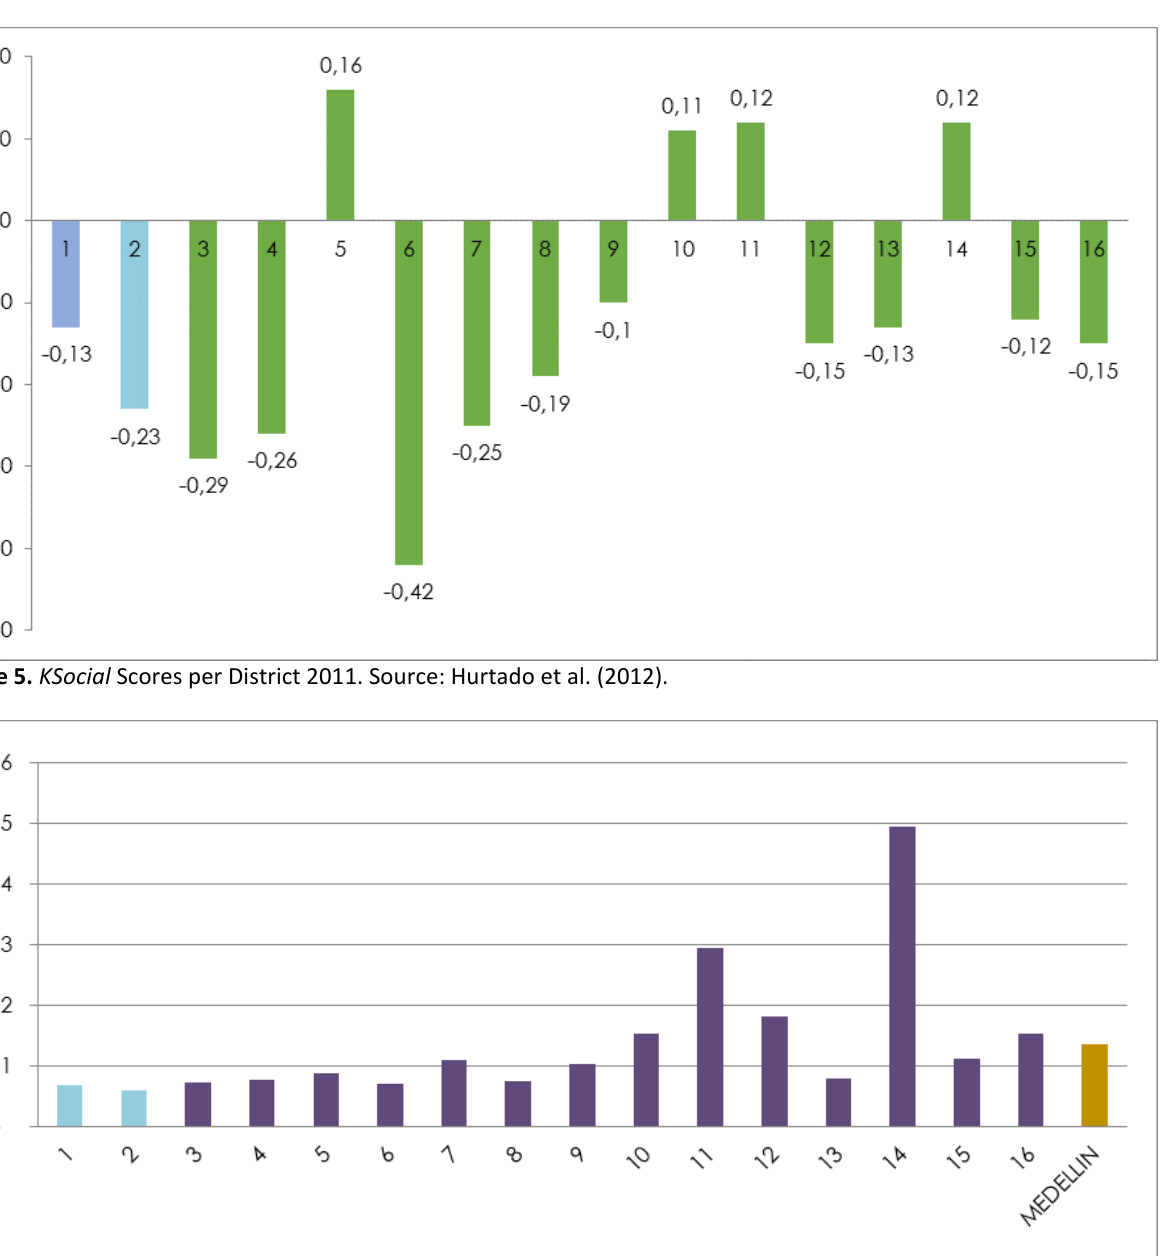
Figure 6 . Average Household Head Monthly Income per District 2012. Source: Alcaldía de Medellín, 2013a.